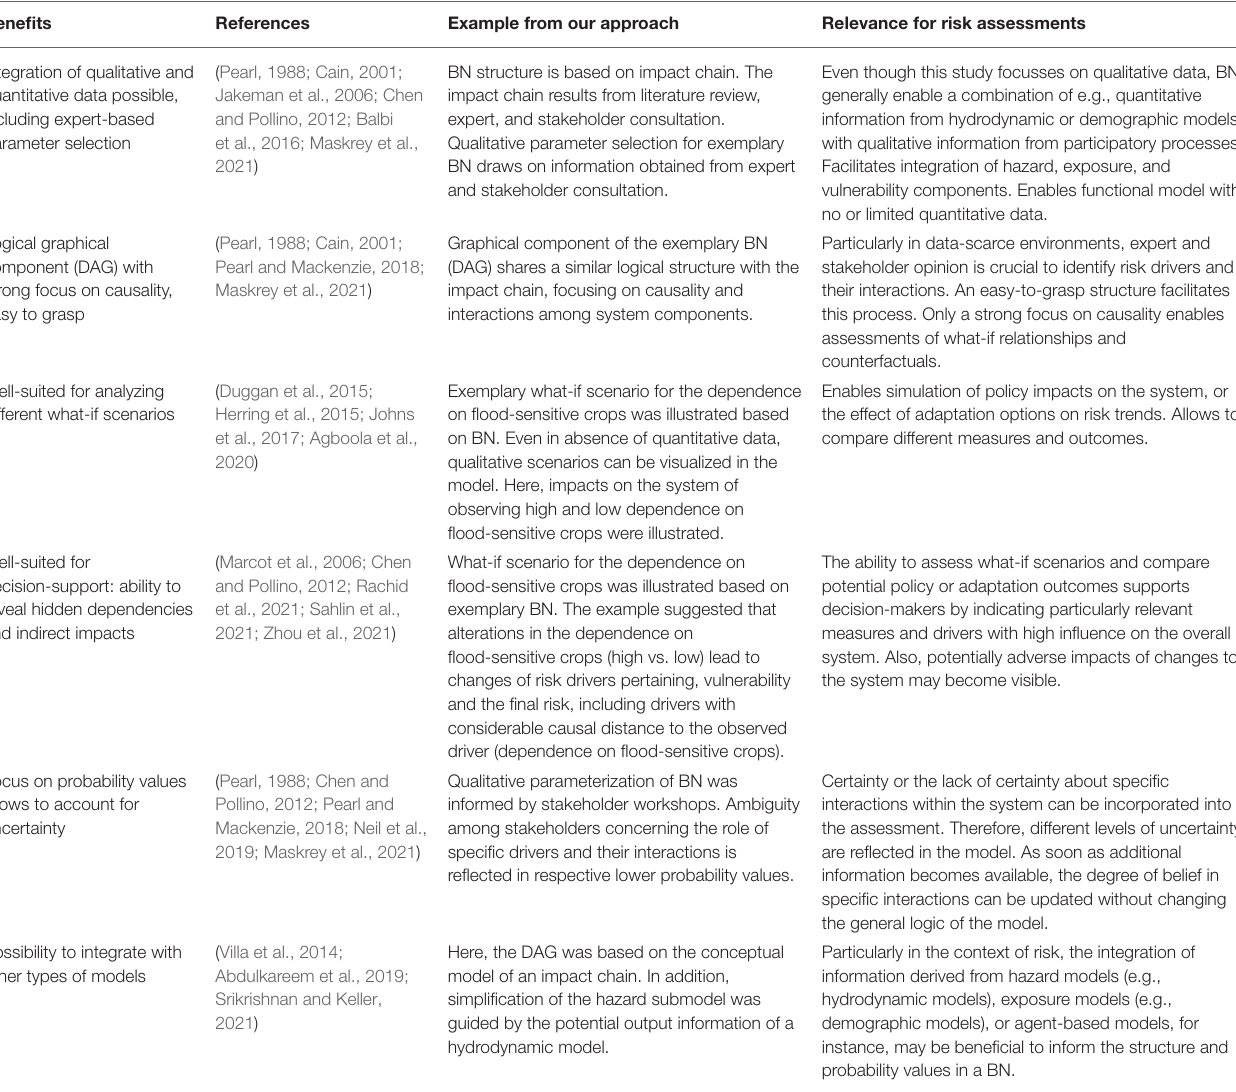
TABLE 2 | Benefits of Bayesian